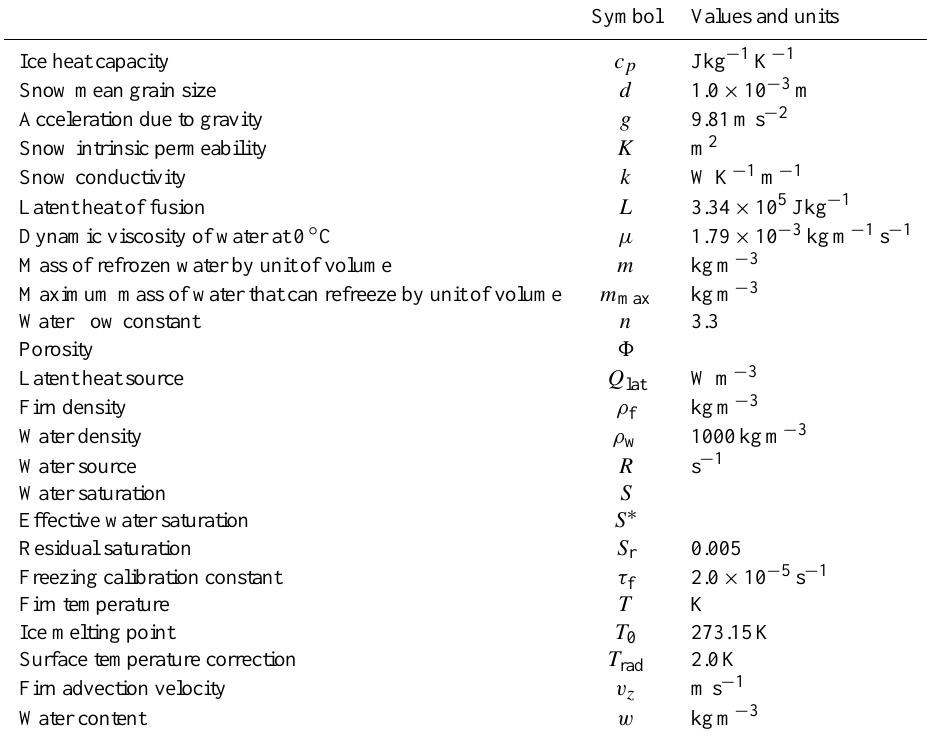
Table 3. Parameters and variables used in the percolation and heat transport model (model 2), with their respective values when available.